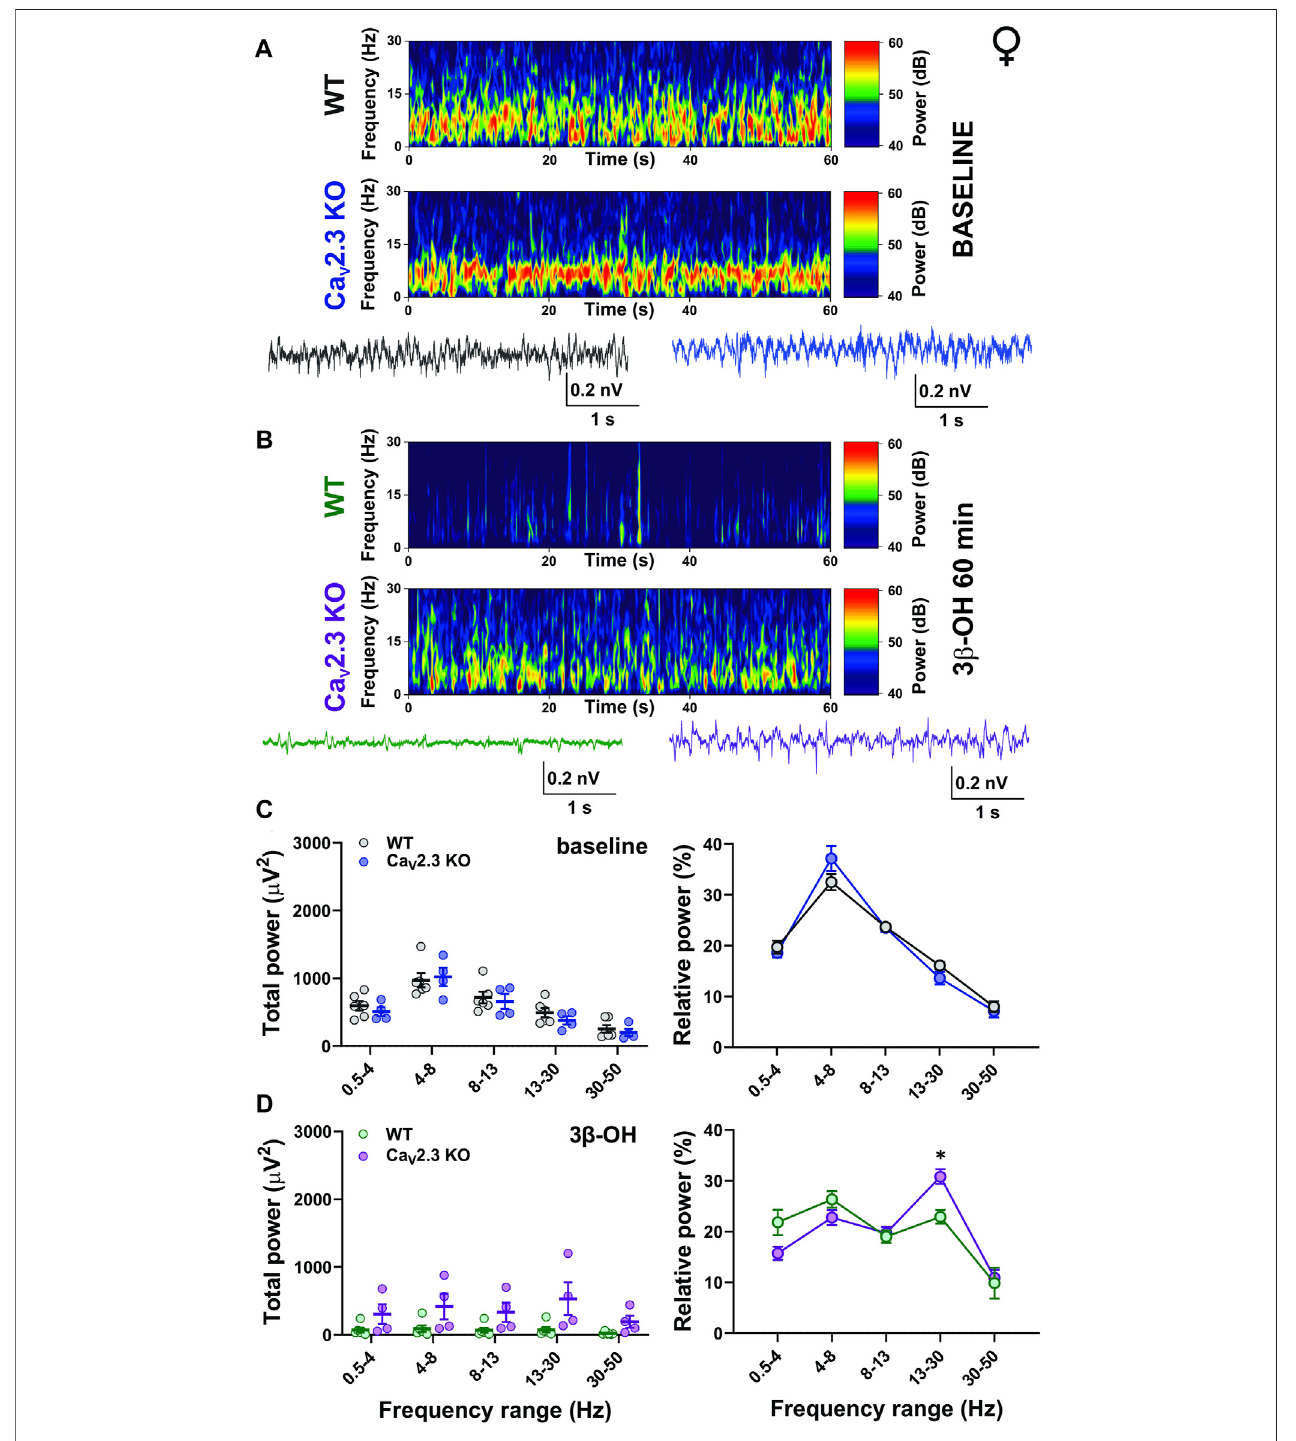
FIGURE 6 | The effects of 3 β -OH on EEG in female WT and Ca V 2.3 KO animals at a time point of 60 min after i.p. injections of 80 mg/kg of 3 β -OH. (A) Representative baseline heat map from a female WT (top) and a Ca V 2.3 KO (bottom) animal with the representative EEG traces (WT, black; Ca V 2.3 KO, blue). (B) Representative heat map from a female WT (top) and a Ca V 2.3 KO (bottom) animal with the representative EEG traces (WT, green; Ca V 2.3 KO, purple) at time point of 60 minafterinjectionsof3 β -OH. (C) Totalpowerduringbaseline(left)andrelativebaselinepower(right). (D) Totalpower(left)andrelativepower(right,two-wayRM ANOVA:interactionF 4,32 =2.90, p =0.004;genotypeF 1,8 =0.09, p =0.771;frequencyF 4,32 =16.44, p < 0.001. Š ídák ’ smultiplecomparisonstestpresented)at60 min after 3 β -OH. N = 6 animals in WT group; N = 4 animals in Ca V 2.3 KO group, * p < 0.05.